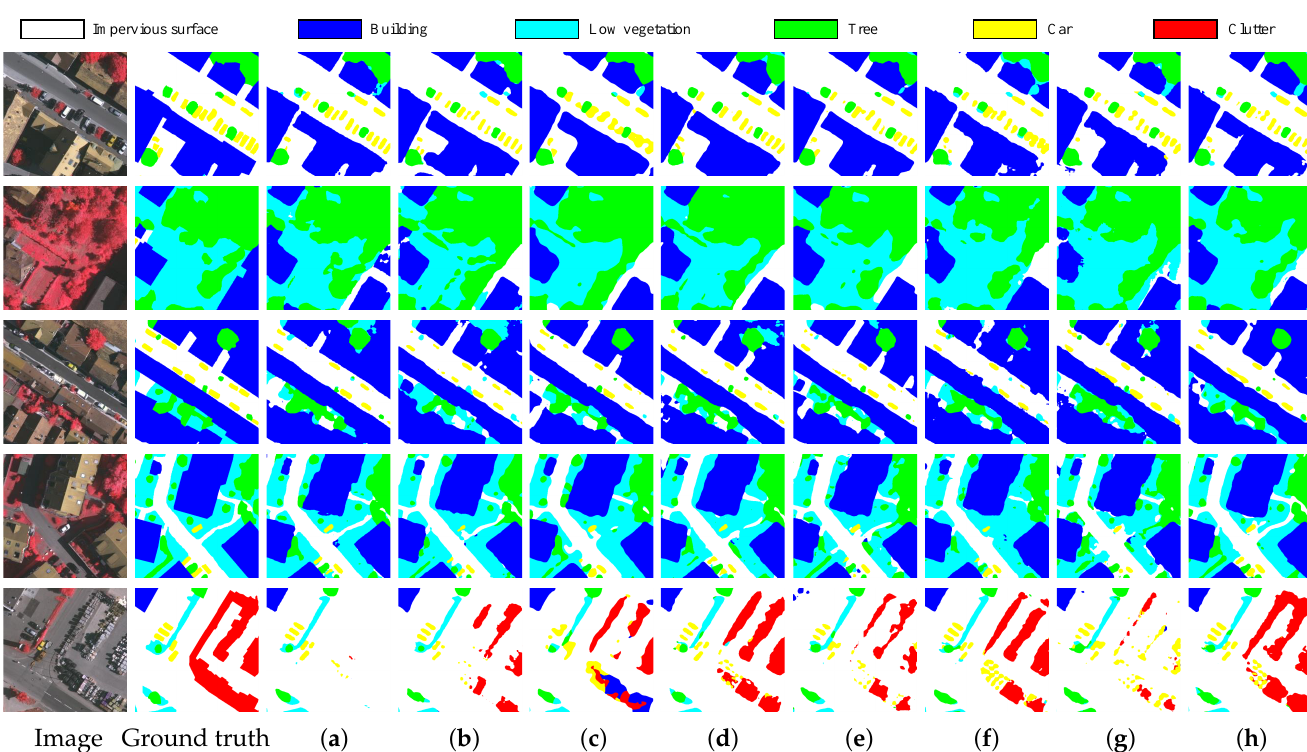
Figure 5. Comparison of visualization results on the ISPRS Vaihingen dataset. ( a ) FCN.